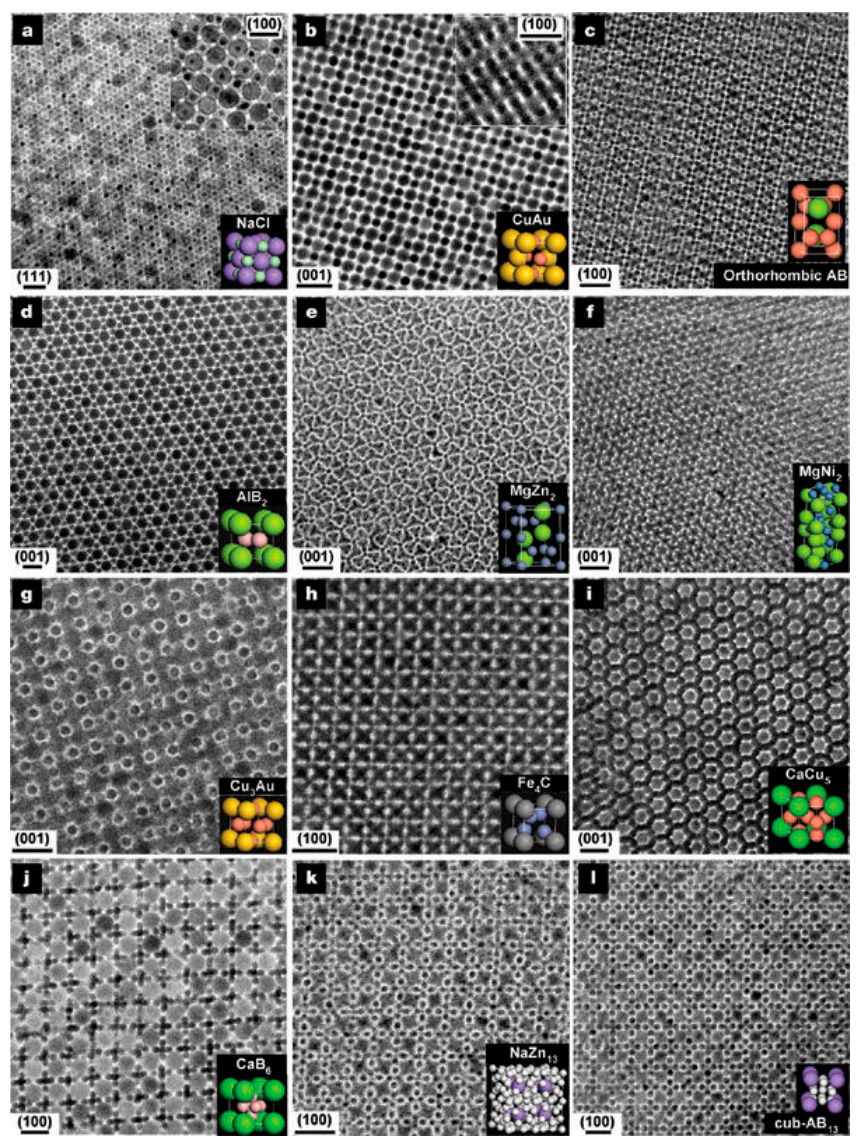
Figure 4. Structural diversity of binary nanocrystal superlattices (BNSLs). ( a ) 13.4 nm g-Fe2O3 and 5.0 nm Au NCs (NaCl-type), ( b ) 7.6 nm PbSe and 5.0 nm Au NCs (CuAu-type), ( c ) 6.2 nm PbSe and 3.0 nm Pd (AB-type), ( d ) 6.7 nm PbS and 3.0 nm Pd (AlB 2 -type), ( e ) 6.2 nm PbSe and 3.0